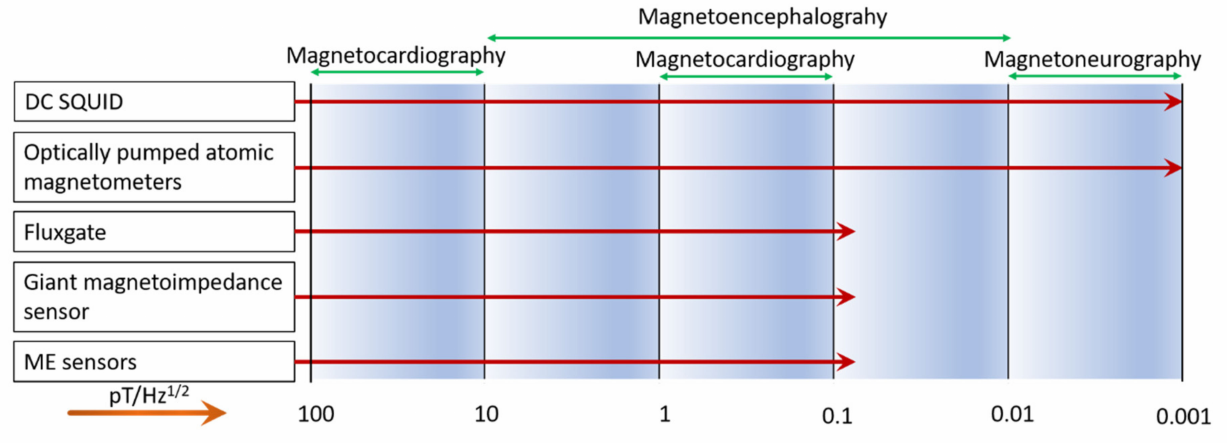
Figure 8. Current available various magnetic field sensors for the detection of biomagnetic signals. Reproduced from ref. [41].